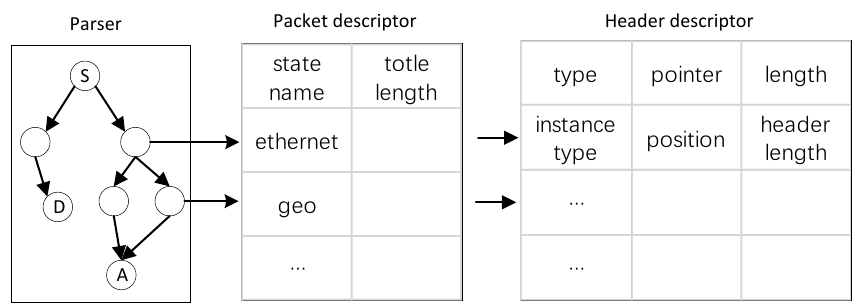
Figure 8. The packet header caching